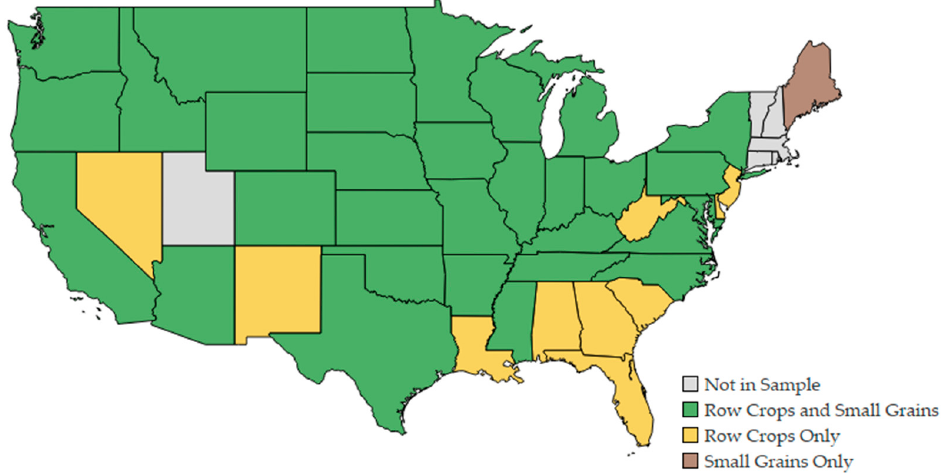
Figure 2. The states for which no (grey) estimate, at least one row crop (yellow) estimate, at least one small grain (brown) estimate, or at least one row crop estimate and one small grain crop estimate (green) are published.